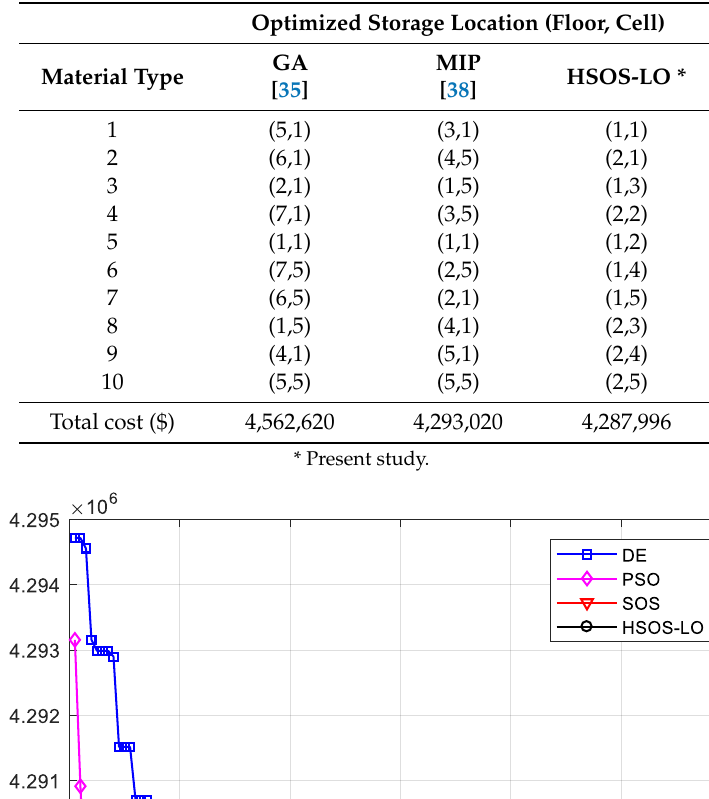
Table 6. The comparative results between HSOS-LO and previous research.